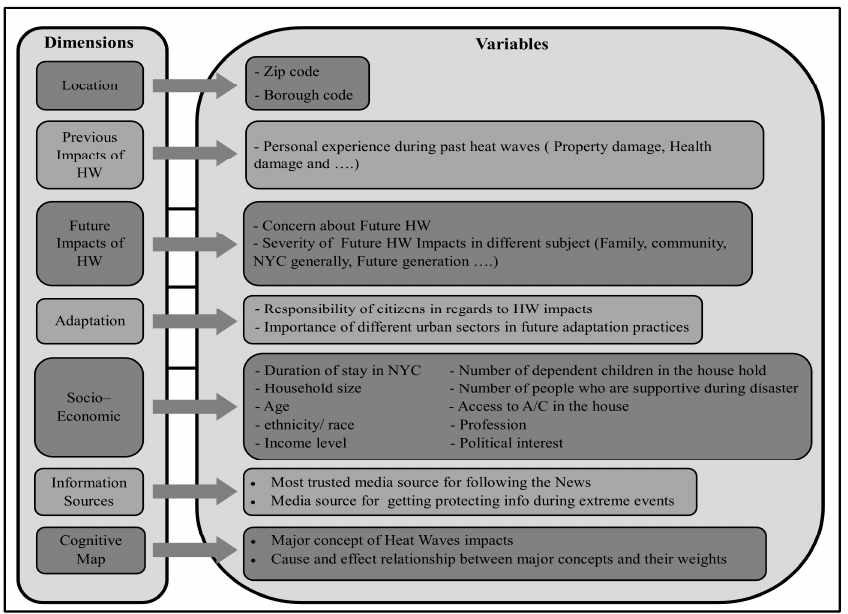
Figure 2. Structure of the dataset.